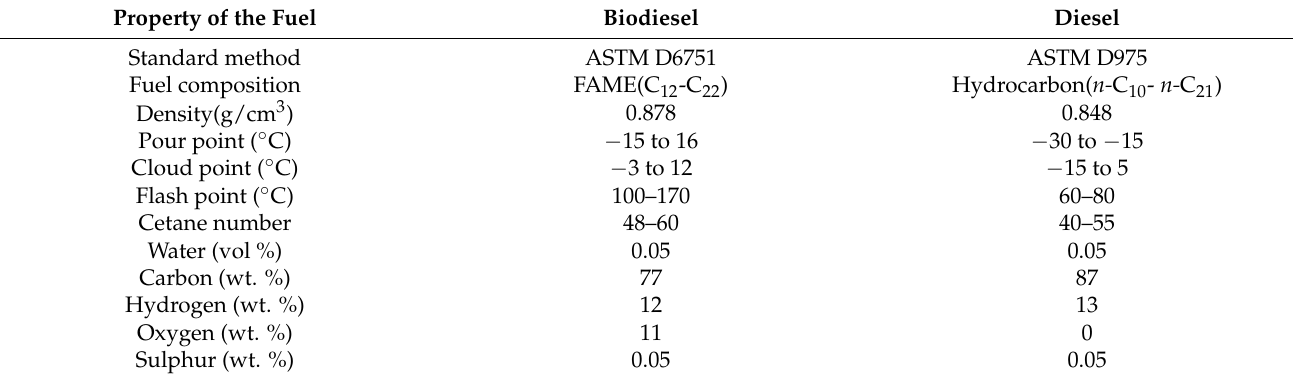
Table 5. Comparison of biodiesel and diesel according to the American Standard for Testing and Materials (ASTM). Property of the